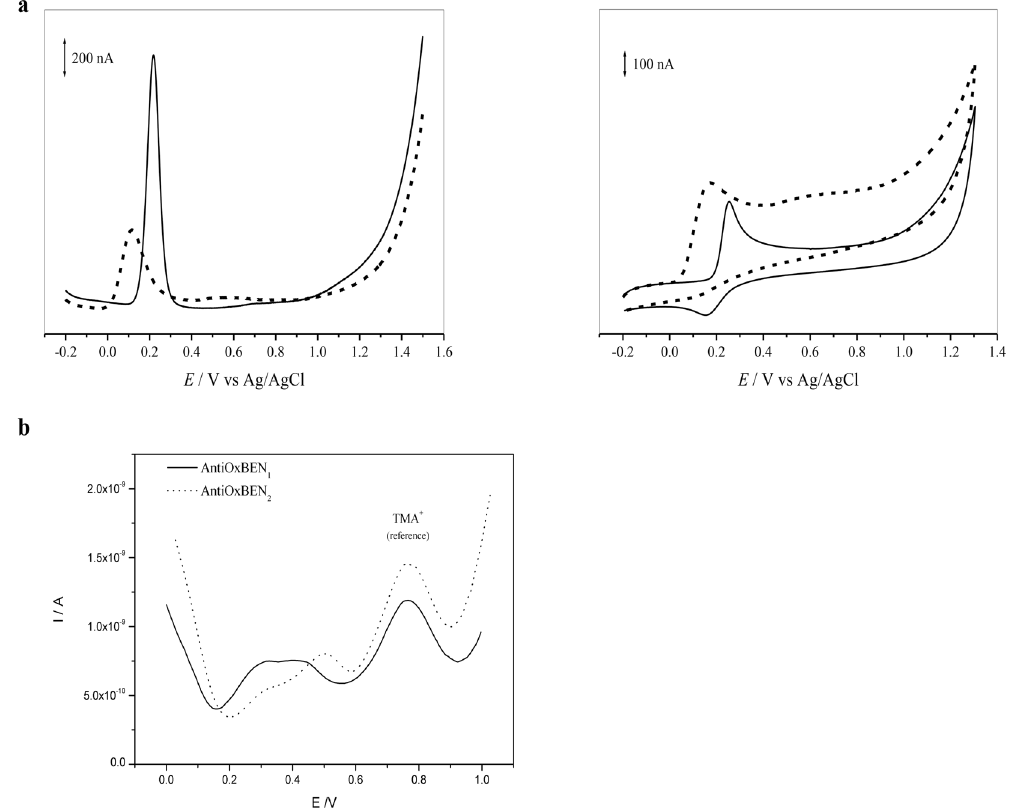
Figure 4. ( a ) Representative AntiOxBENs voltammograms: (upper panel) Differential pulse and (lower panel) cyclic voltammograms for a 0.1 mM solution of ( ▬ ) AntiOxBEN 1 and ( ●●● ) AntiOxBEN 2 at physiological pH 7.4 supporting electrolyte. Scan rate: 5 mV s − 1 (DPV) and 20 mV s − 1 (CV). ( b ) Evaluation of AntiOxBENs lipophilicity in water/DCH. Differential pulse voltammograms representing the transfer of 0.1 mM of AntiOxBEN 1 ( ▬ ) and AntiOxBEN 2 ( ●●● ) at the water/DCH micro-interface at physiological pH 7.4. [TMA + ] = 0.13 mM. Scan rate: 8 mV s − 1